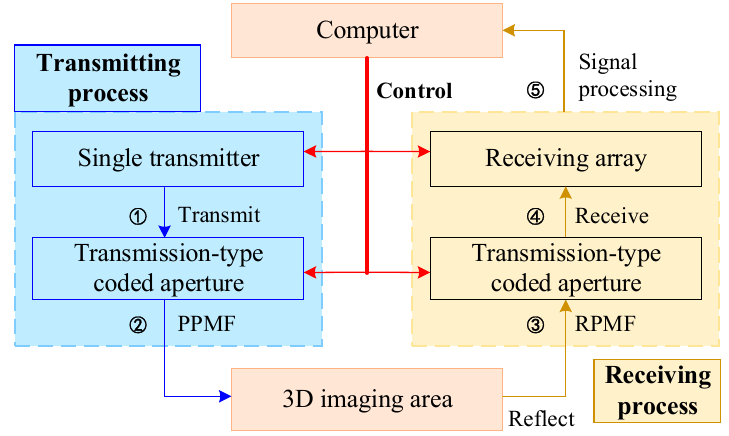
Figure 3. The imaging process of the proposed single input multiple output (SIMO) TCAI architecture.